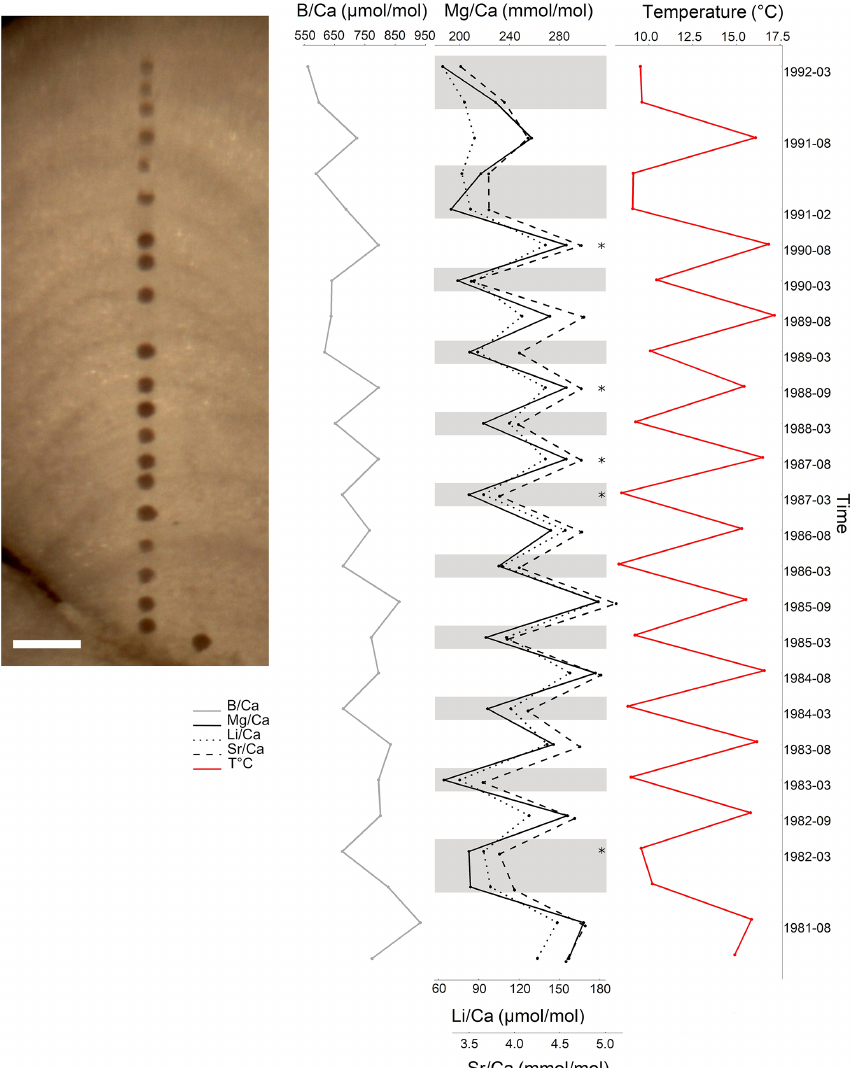
Figure 12. Elemental ratios in L. corallioides collected in Morlaix Bay (scale bar: 200µm). Mg, Li, and Sr / Ca show cyclic variations mirroring the local seawater temperature. In the timeline, the coldest and the warmest months have been reported, which correspond to dark and light bands of growth. Element / Ca ratios in the missing bands (asterisks) have been calculated as the means of the values measured in warm or cold periods. Monthly means of temperature have been extracted by ORAS5